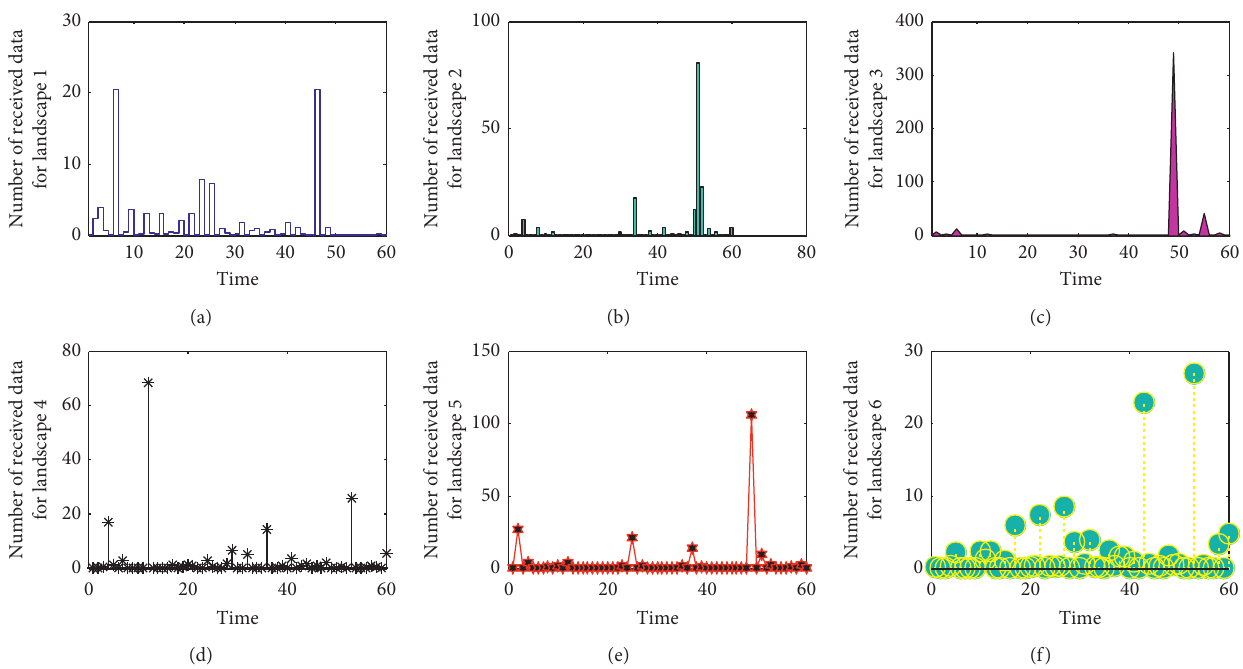
Figure 7: Statistics and visualization of data received by 6 landscape IoT